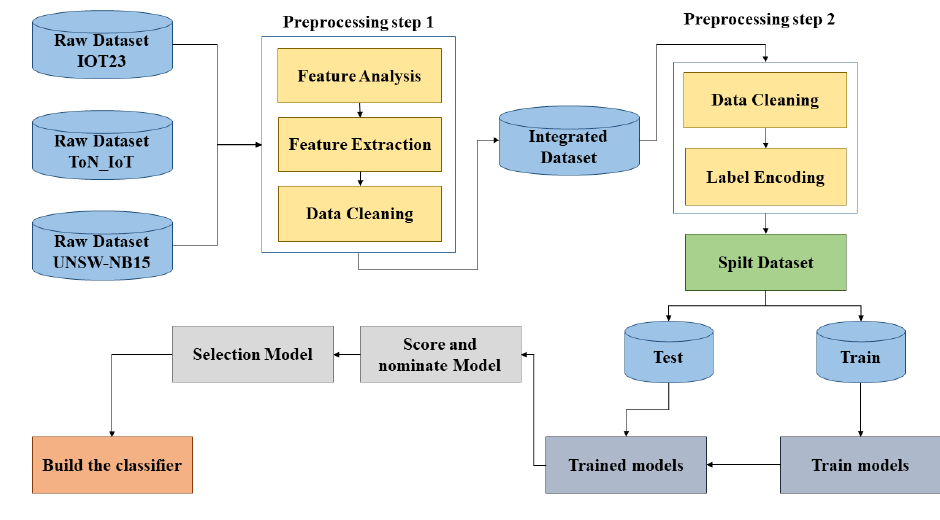
Figure 2. Data Pre-Processing and integration.